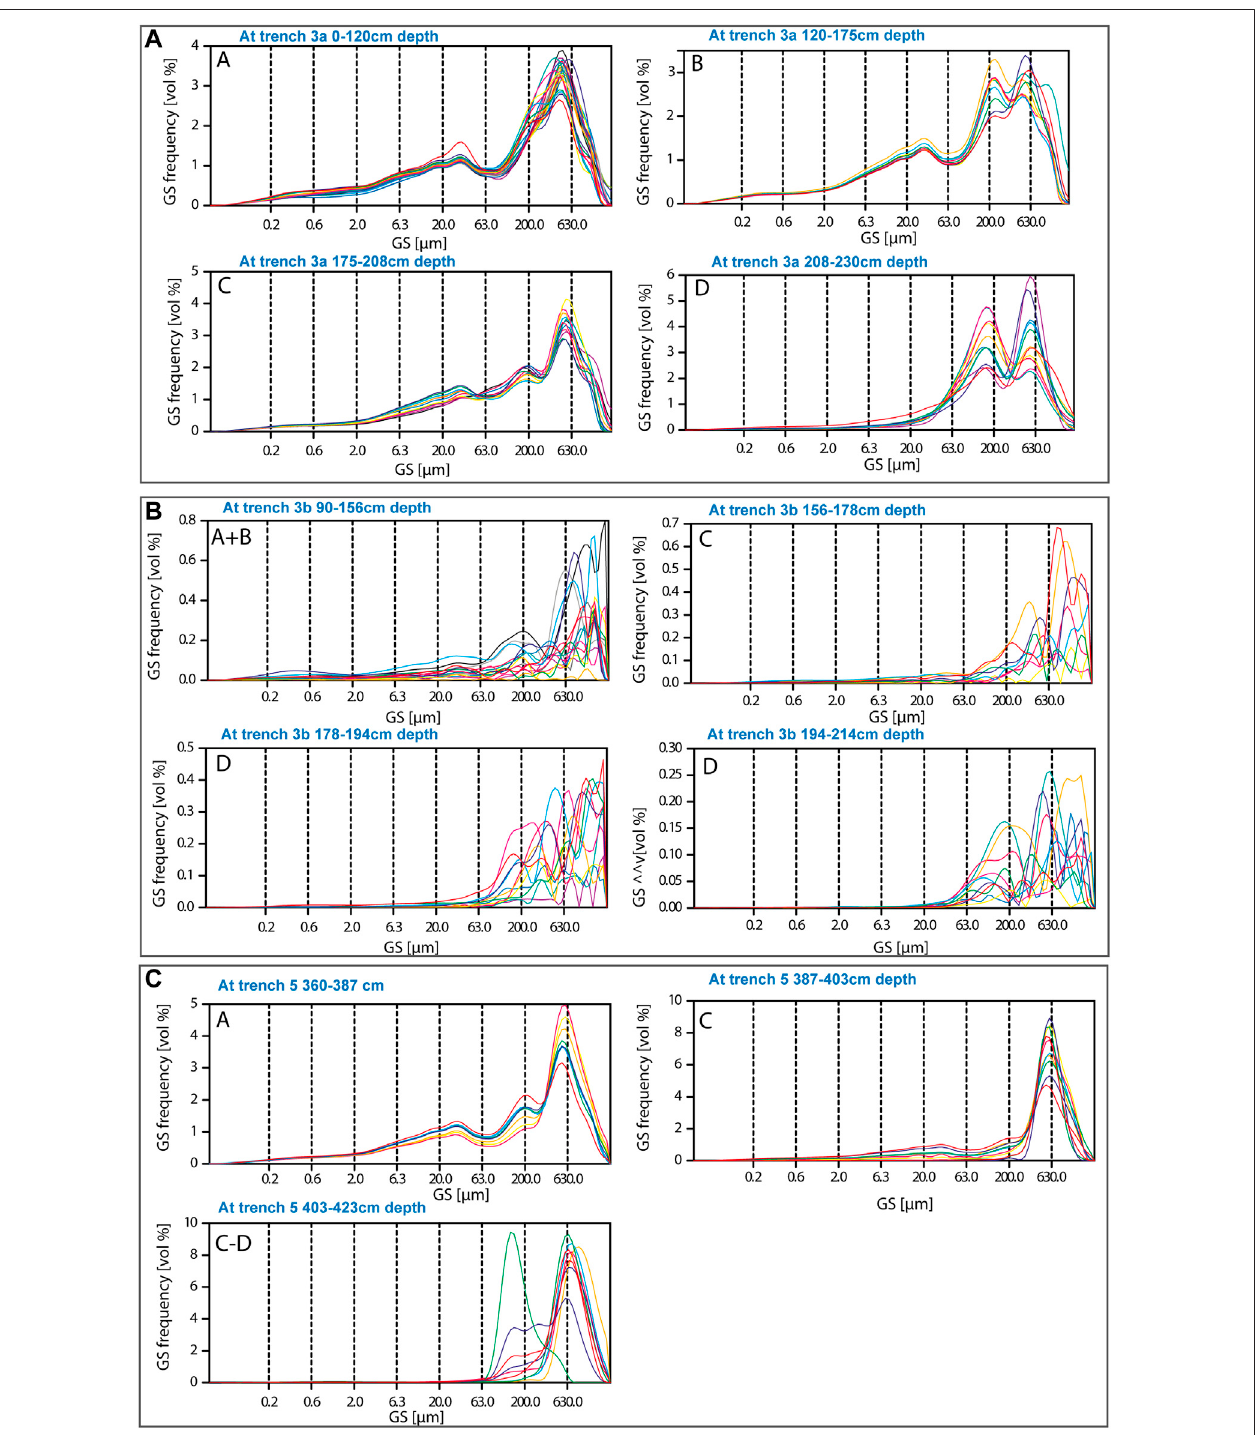
FIGURE 7 | Grain size distribution of At trench 3A (A) , trench 3B (B) , and trench 5 (C) . Position according to stratigraphy is indicated by A – D ; see Figure 2 . In trench5onlyonesamplerepresentsthe fi newhitesandsofunitDbecausesamplingdidnotcontinuefurtherdown.Randomcolorsareusedtodifferentiatebetweenthe single samples.